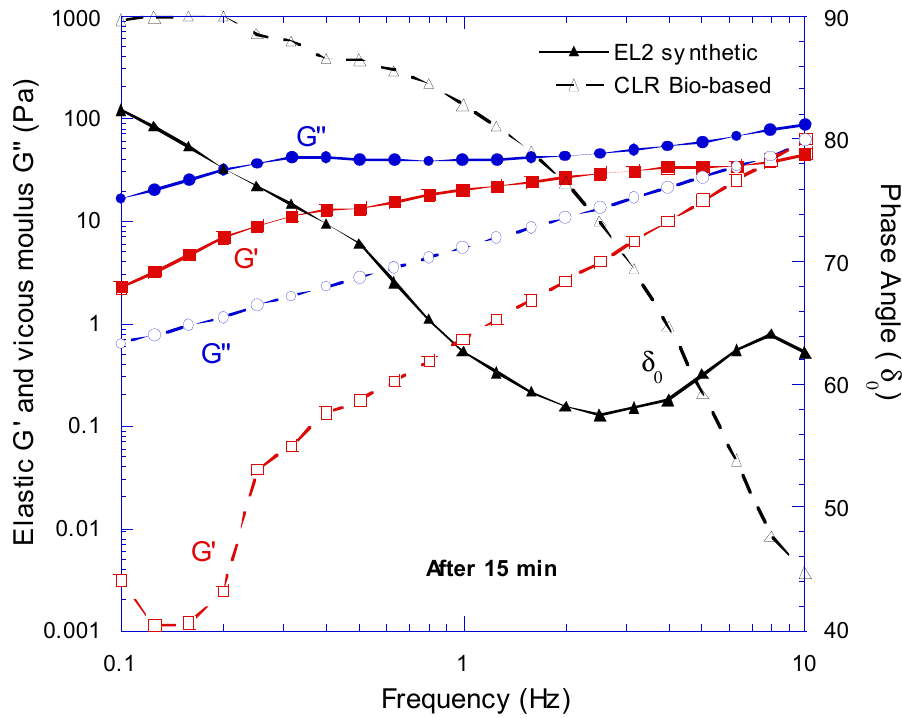
Figure 9. Comparison of frequency sweep test results of CLR bio-based (dash lines) and EL2 synthetic (solid lines) epoxies after 15 min hardener mixing.